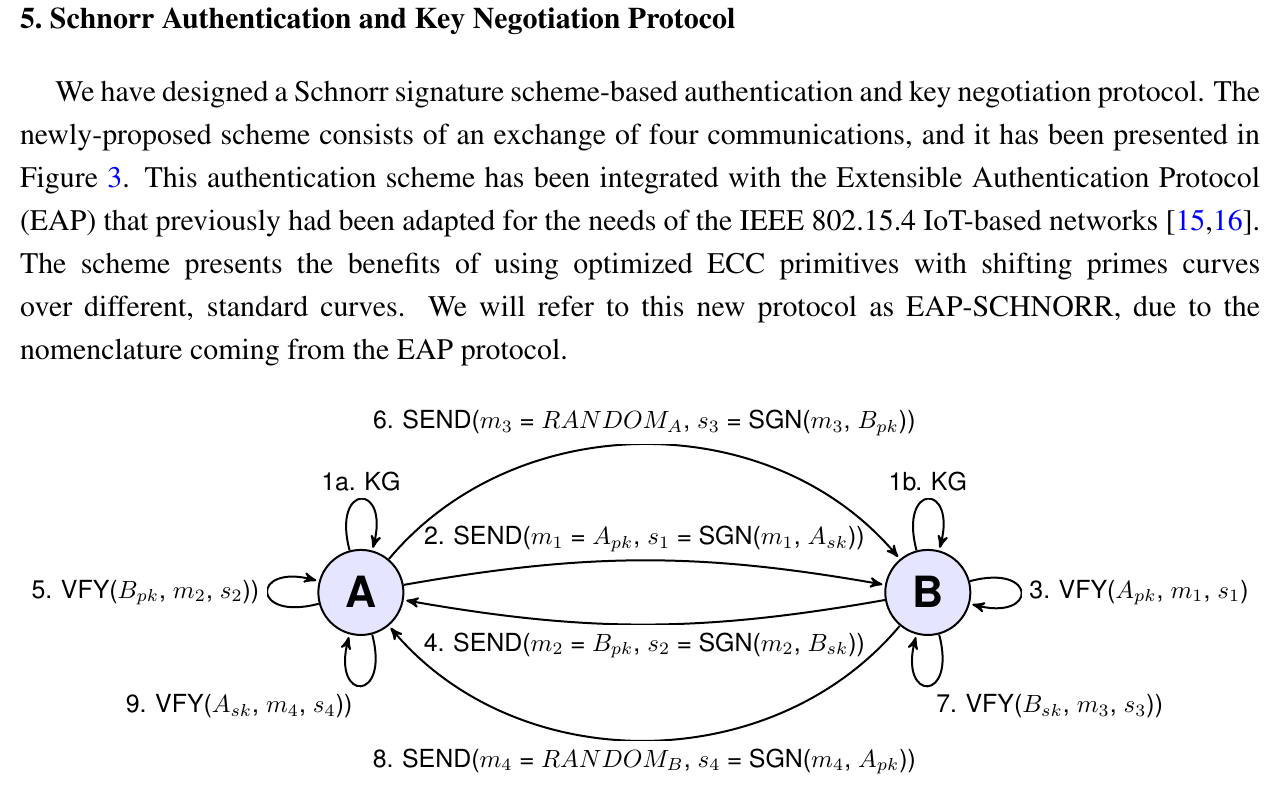
Figure 3. Schnorr signatures scheme-based authentication and key negotiation